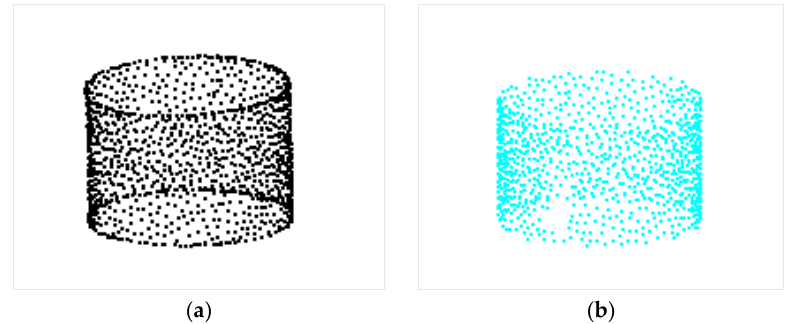
Figure 17. Display of boundary misclassification points in the connecting piece model: ( a ) cylindrical surface in the original model; ( b ) extracted cylindrical surface.